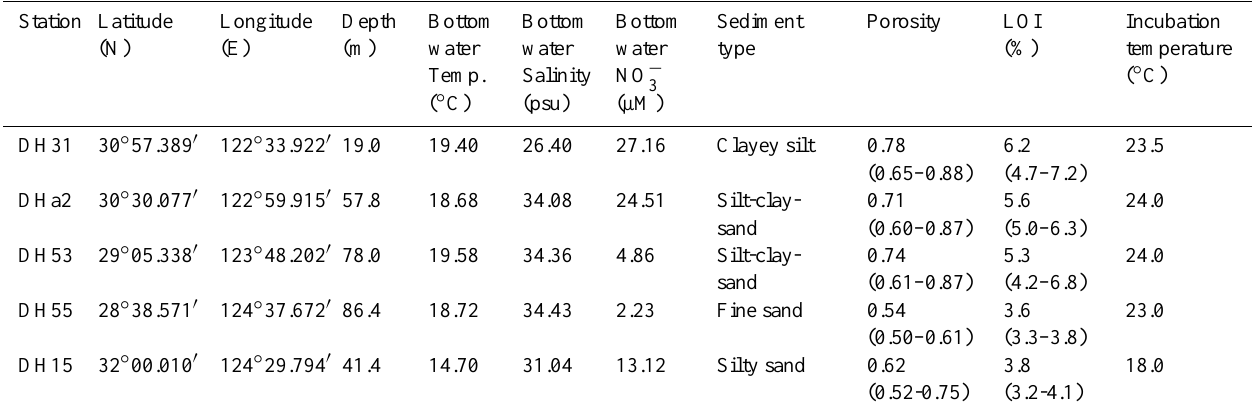
Porosity Incubation